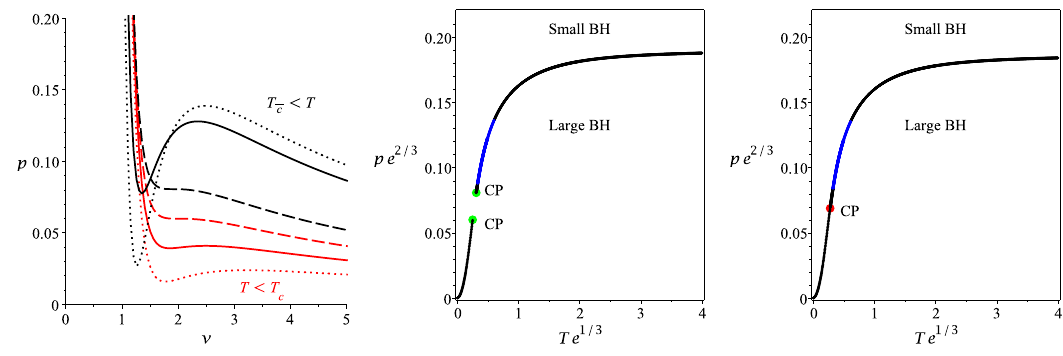
Figure 14 . Two (cid:12)rst order phase transition in six dimensions for d = 6 and k = 1 (color online). Left : a low temperature VdW transition with critical temperature T = T c (dashed red line), T = 0 : 8 T c ; 0 : 6 T c (solid, dotted red lines), and a higher temperature reverse VdW transition with T = T (cid:22) c (dashed black line), T = 1 : 6 T (cid:22) c ; 1 : 8 T (cid:22) c (solid and dotted black lines). Center : the phase diagram for six dimensional spacetimes. The green dots denote the critical points and the black lines show that there are two (cid:12)rst order phase transition for temperatures less and larger than the two critical points. Blue lines correspond to negative entropy. We have chosen e = 1, (cid:12) 3 = (cid:0) 2 e 4 = 3 and (cid:11) 4 = (cid:0) 9 = 5 e 2 with T c e 1 = 3 (cid:25) 0 : 31392, P c e 2 = 3 (cid:25) 0 : 08065 and T (cid:22) c e 1 = 3 (cid:25) 0 : 25527, P (cid:22) c e 2 = 3 (cid:25) 0 : 05998. Right : for e = 1, (cid:12) 3 (cid:25) (cid:0) 2 : 05912 e 4 = 3 and (cid:11) 4 = (cid:0) 9 = 5 e 2 we obtain an isolated critical point (red point); the approximate values at the conjoined critical temperature and pressure are T c e 1 = 3 (cid:25) 0 : 28047 and P c e 2 = 3 (cid:25) 0 :